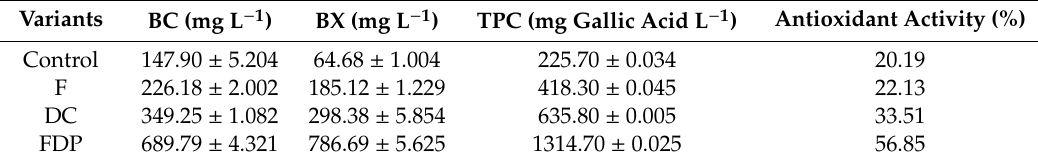
Table 2. Phytochemical features of the F, DC, and FDP experimental variants—The experimental variants were compared to the control (fresh beetroot cubes without LAB).